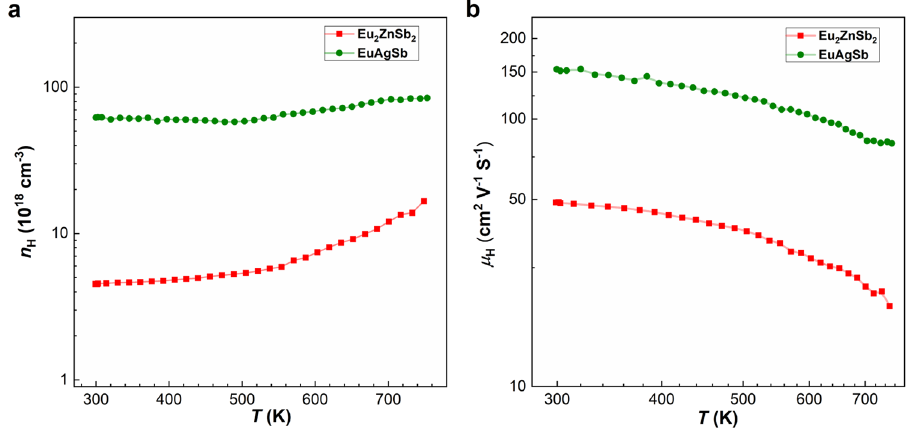
Fig. 2 Temperature-dependent Hall data. a Carrier concentration and b Hall mobility of Eu 2 ZnSb 2 and EuAgSb 33